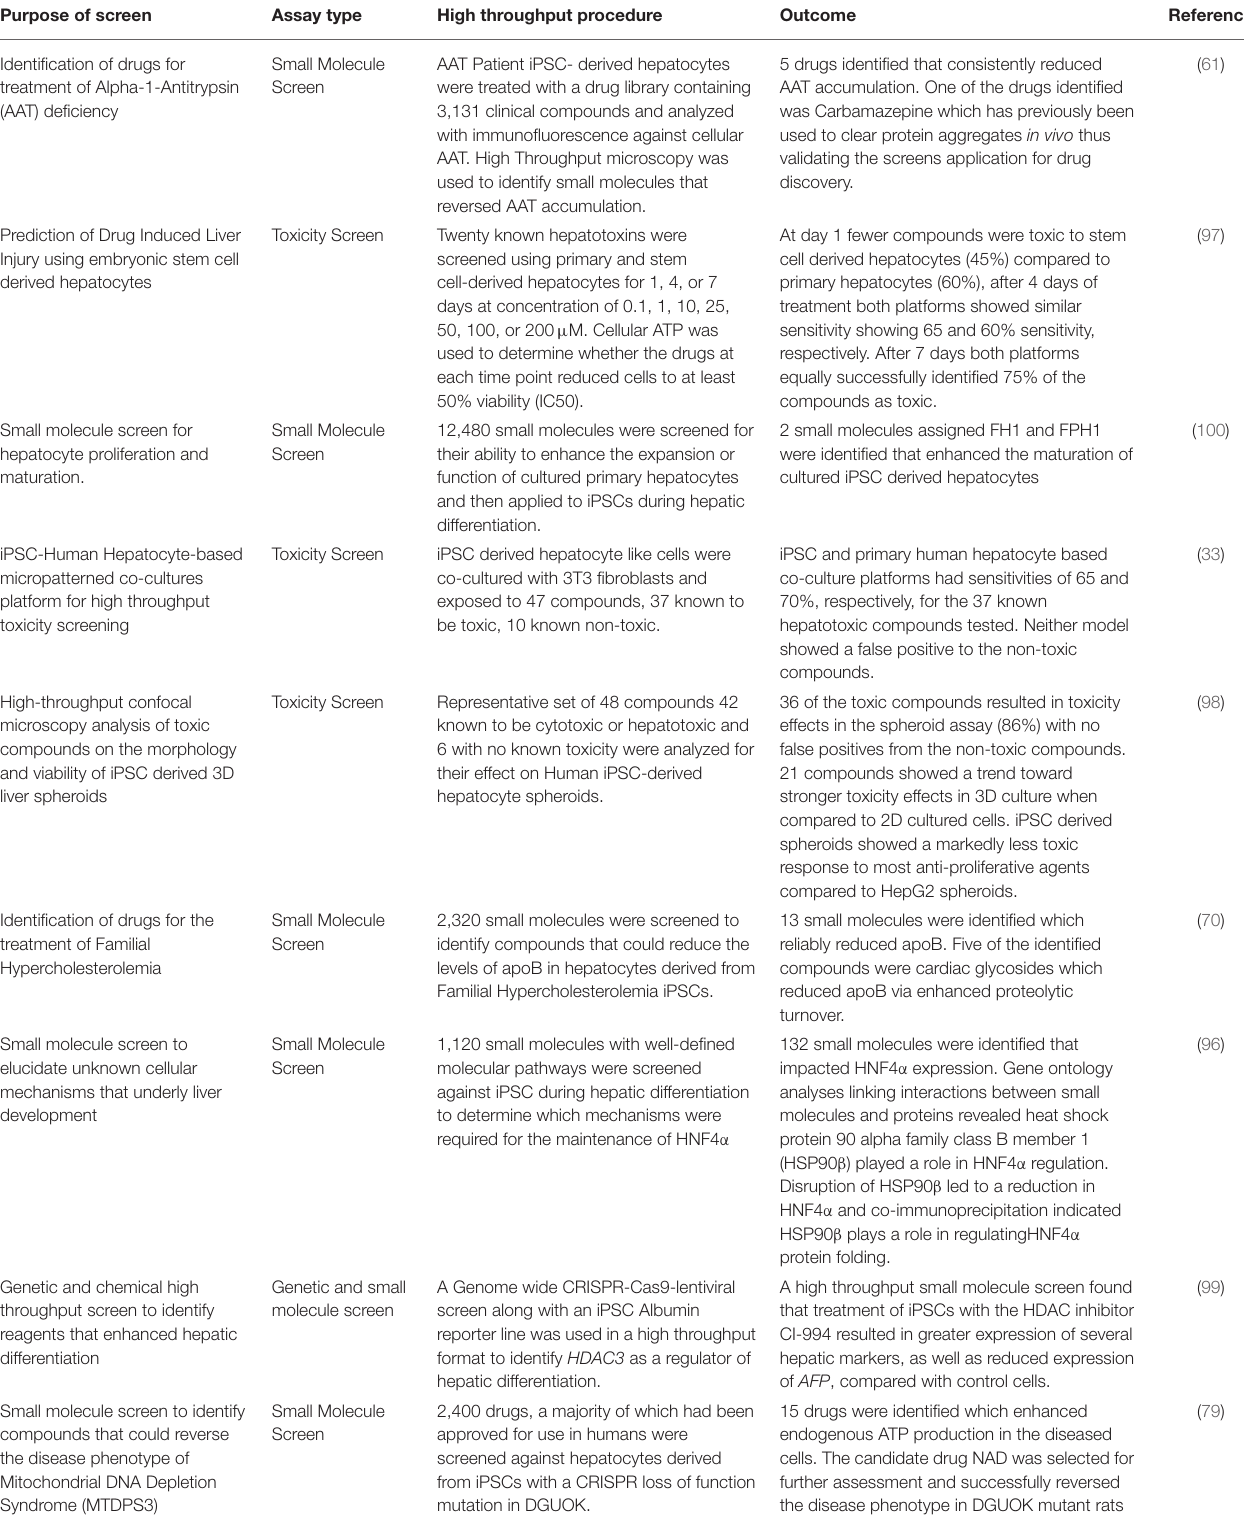
TABLE 2 | High throughput platforms for drug discovery and toxicology assessment using iPSC derived